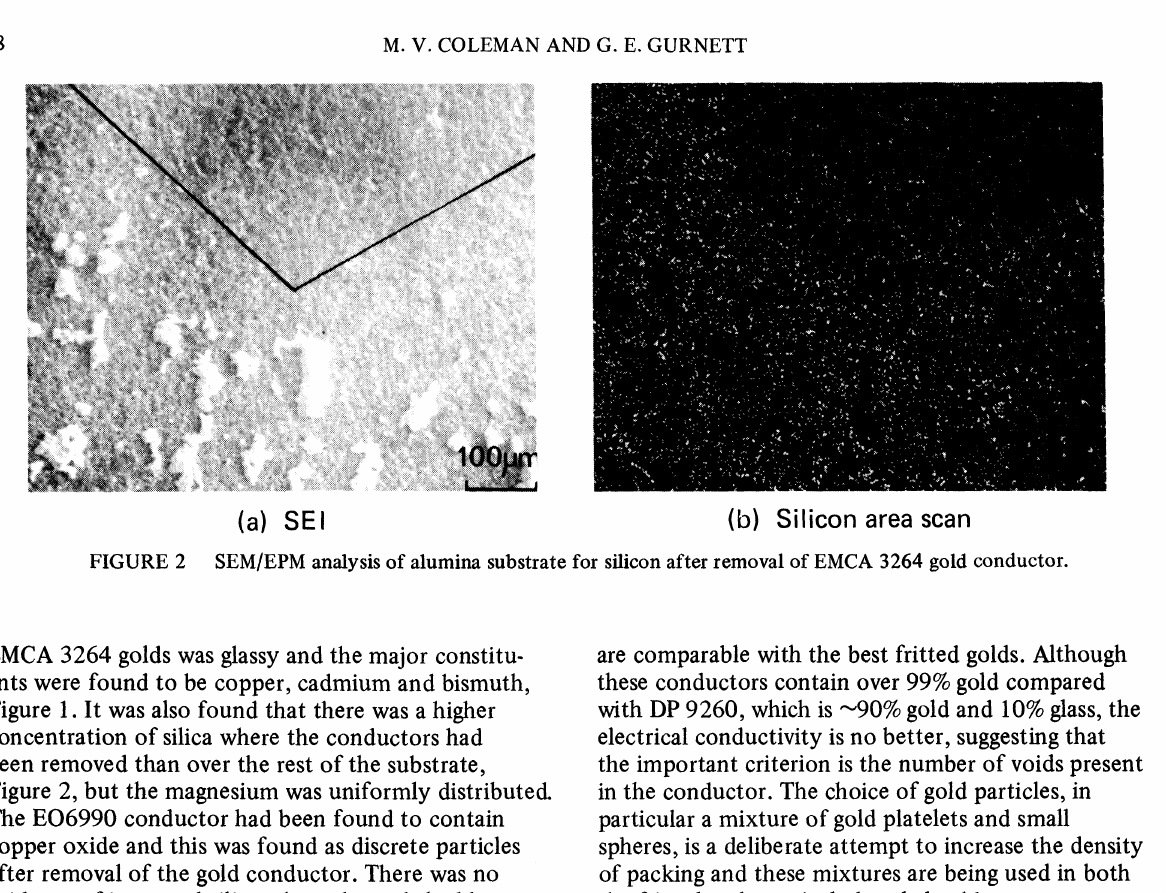
(a) SEI (b) Silicon area scan SEM/EPM analysis of alumina substrate for silicon after removal of EMCA 3264 gold FIGURE 2